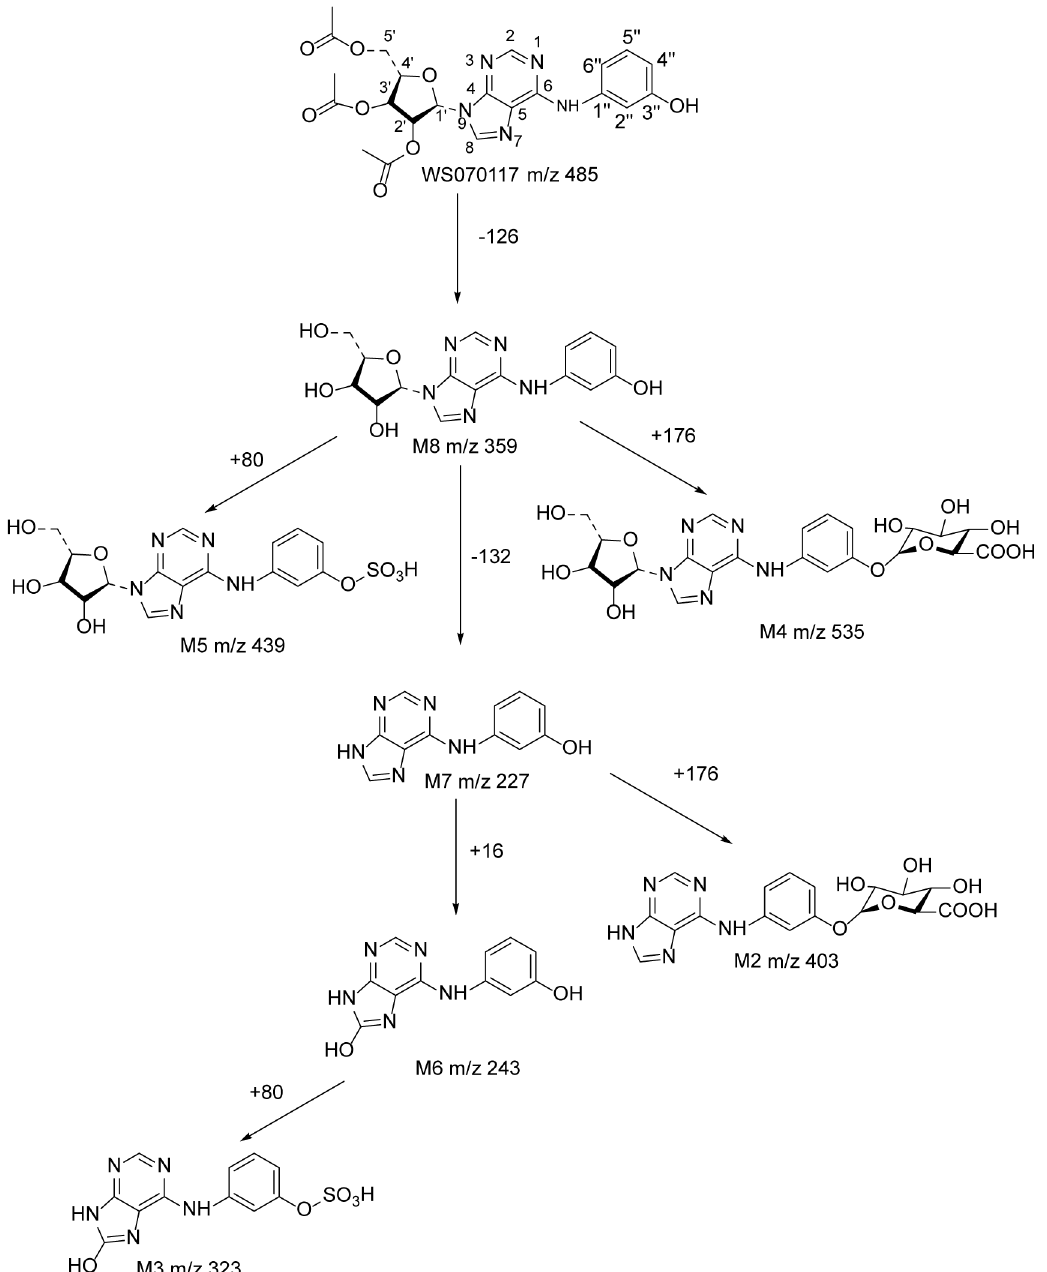
Fig 6. Structures of WS070117 metabolites in rat urine and the proposed metabolic pathways.